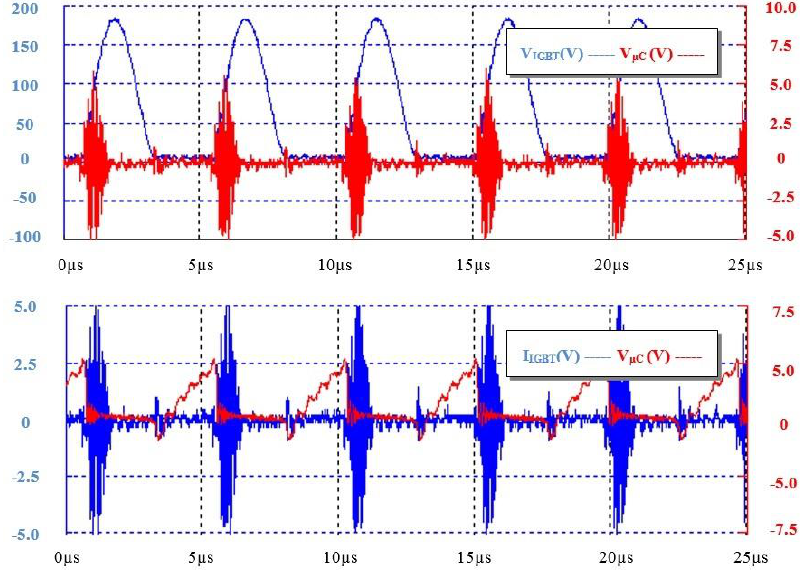
Figure 7. System characterisation data—TX microcontroller (VµC) control signal versus IGBT transistor switching voltage (V IGBT ) and current (I IGBT